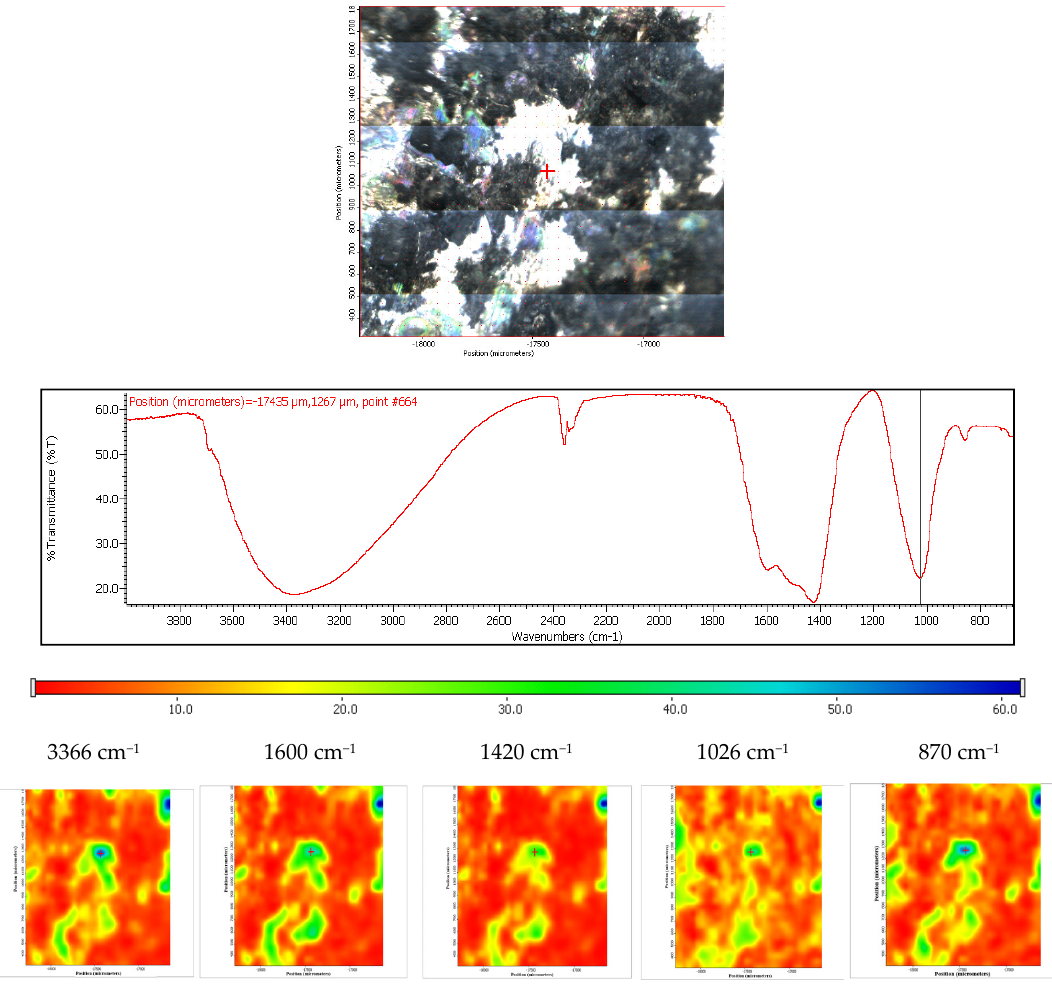
Figure 19. FTIR diagram and chemigram maps of the coated ZM21 alloy exposed to SBF. In the upper part, a dark field optical image, corresponding to the investigated area, is presented. In the lower part, false colour maps with the indicated reference bands are shown. The chemigram scale bars are expressed in μm.